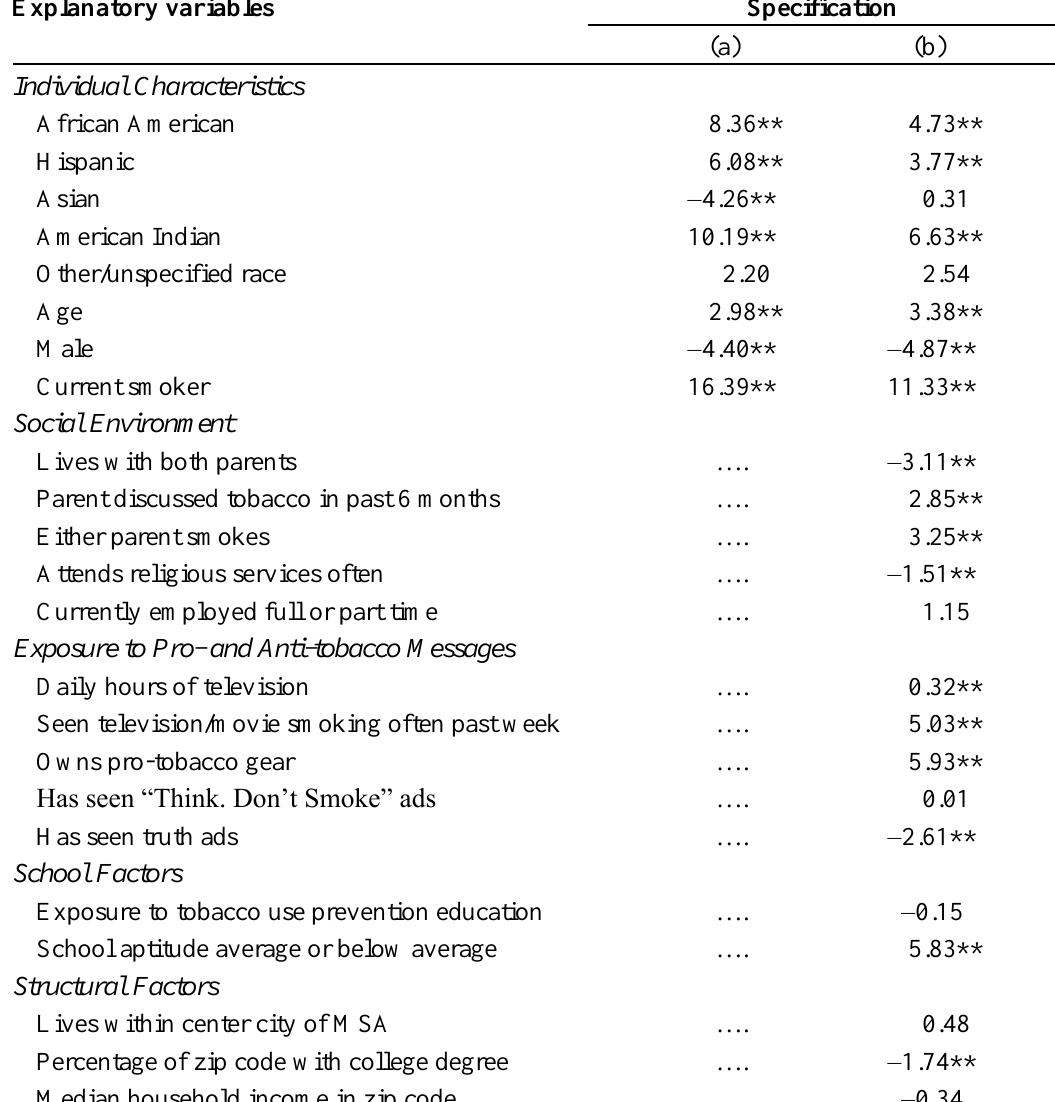
Table 2. OLS regression models showing the association between perceived smoking and contextual